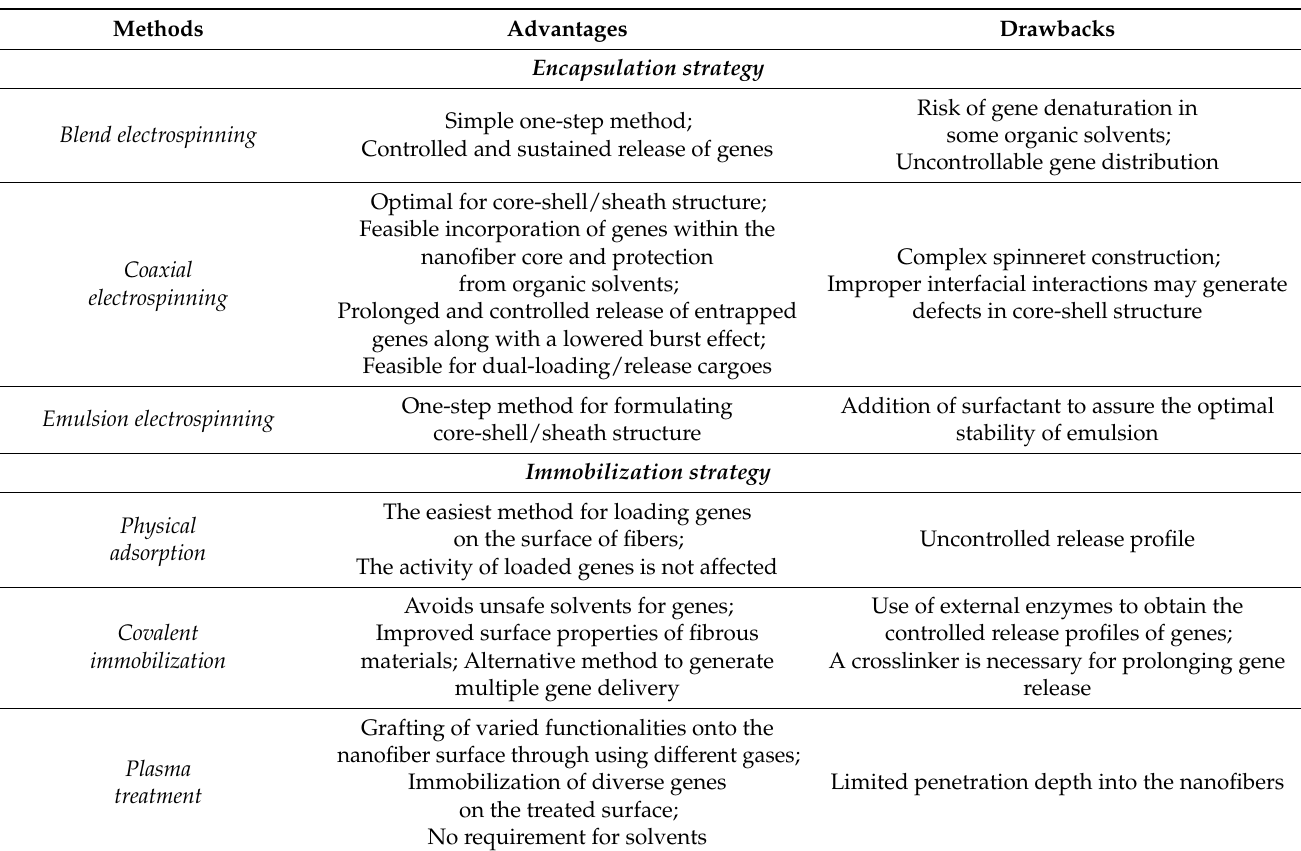
Table 3. Summary of the main advantages and drawbacks of strategies for formulating fibrous architectures for controlled gene therapy drug delivery